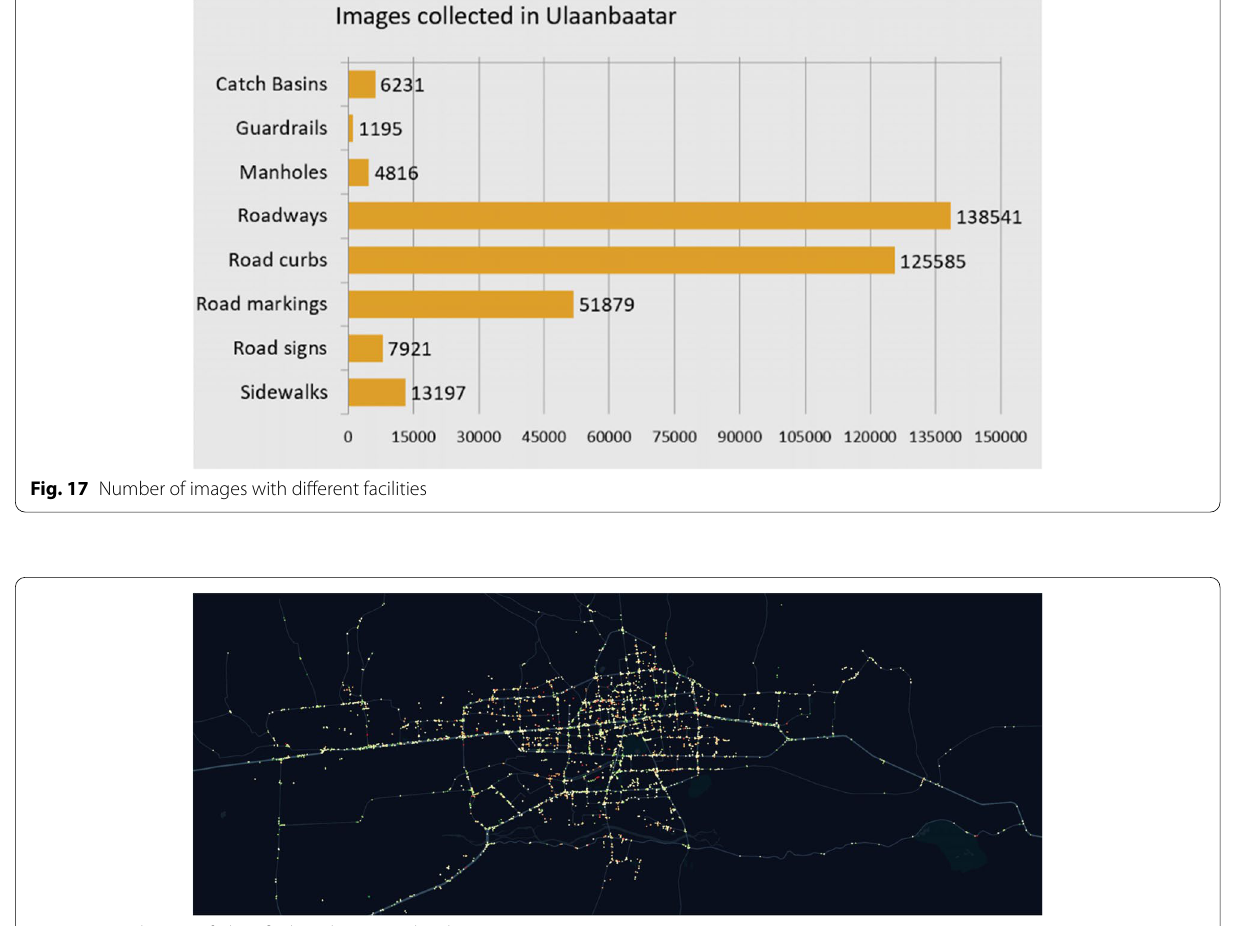
Fig. 18 Distribution of identified road signs in